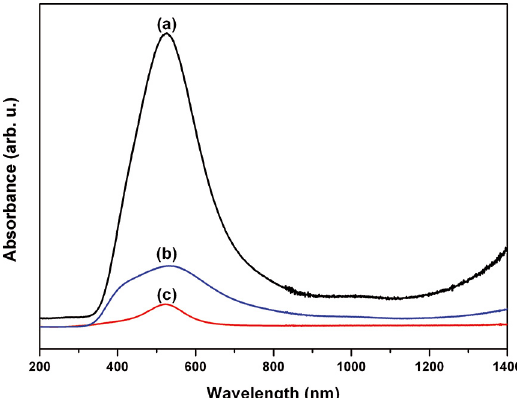
(OH)PO 2 4 ) •3H 3 2 2